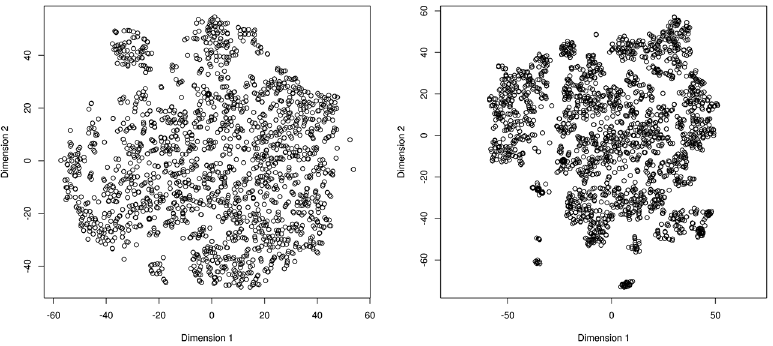
Fig 2. The results of applying t-SNE on contextual information. The transformed contextual information for (A) cloned lilac and (B) common